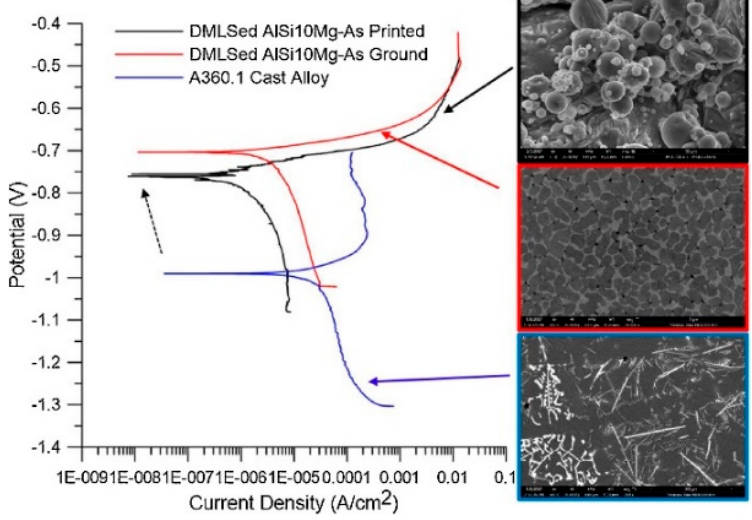
Figure 6. The polarization curves of printed, ground and casted aluminum alloy produced by DMLS DMLS [90].